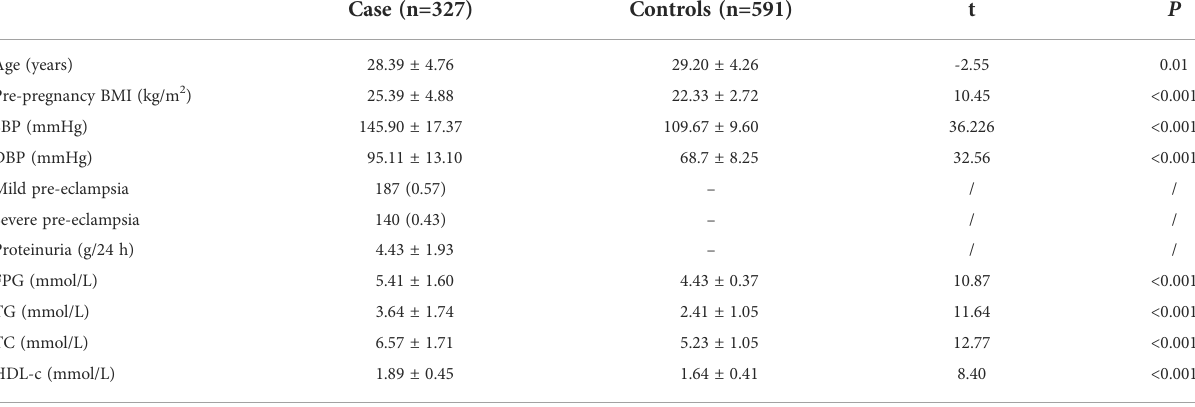
TABLE 2 Demographic and clinical characteristics in PE cases and controls ( x ±